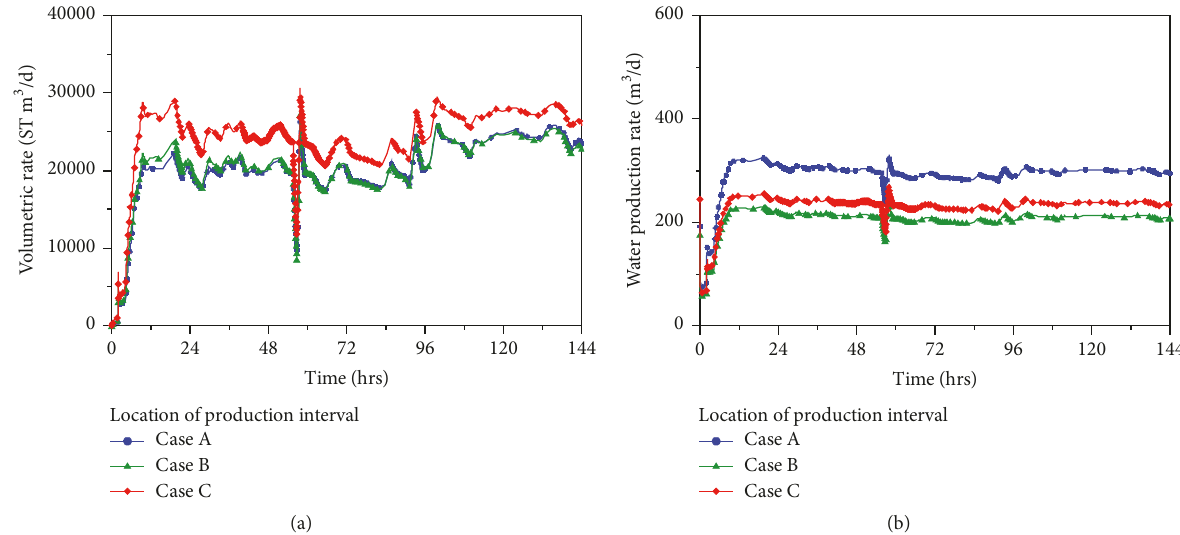
Figure 17: Evolution of volumetric rates of (a) gas production and (b) water production from hydrate reservoirs under different locations of production